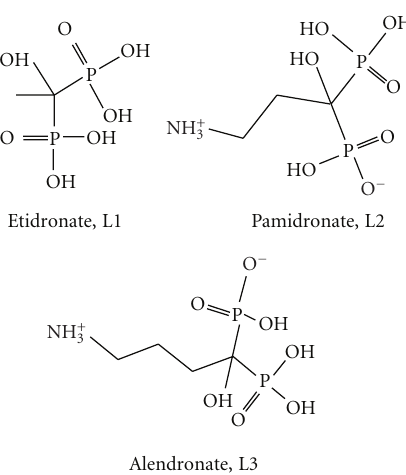
Scheme 2: Molecular structures of etidronate, pamidronate, and alendronate and abbreviations used in the document.